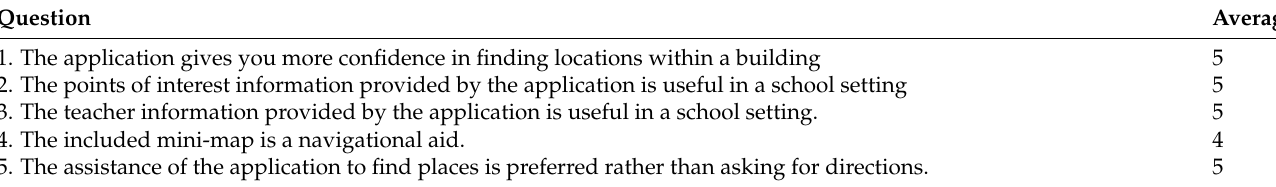
Table 5. Average result of the survey applied on a Likert scale. 1 = Strongly disagree, 2 = Disagree, 3 = No preference, 4 = Agree, 5 = Strongly